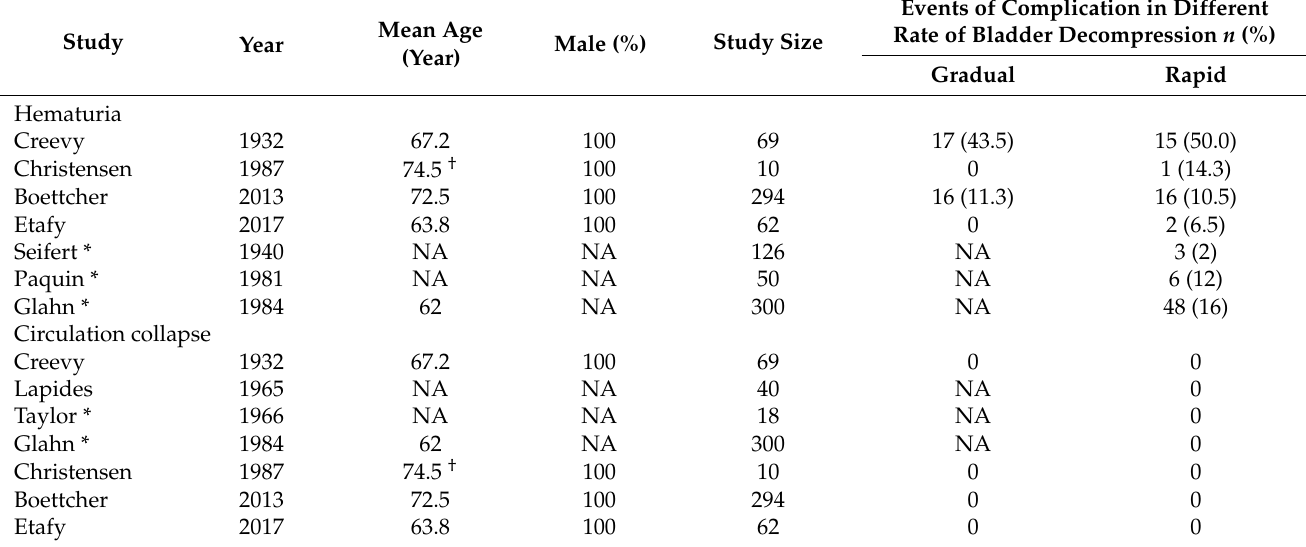
Table 5. Events of hematuria and circulatory collapse in rapid and gradual bladder decompres- sion groups.